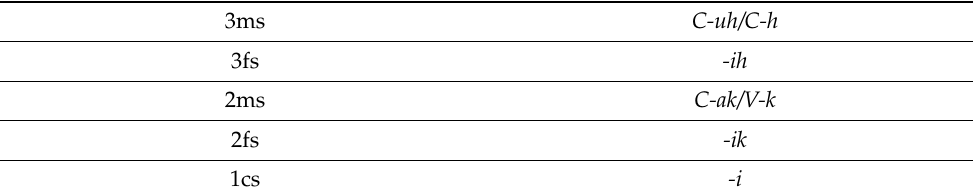
Table 4. ˇGiblah Forms.